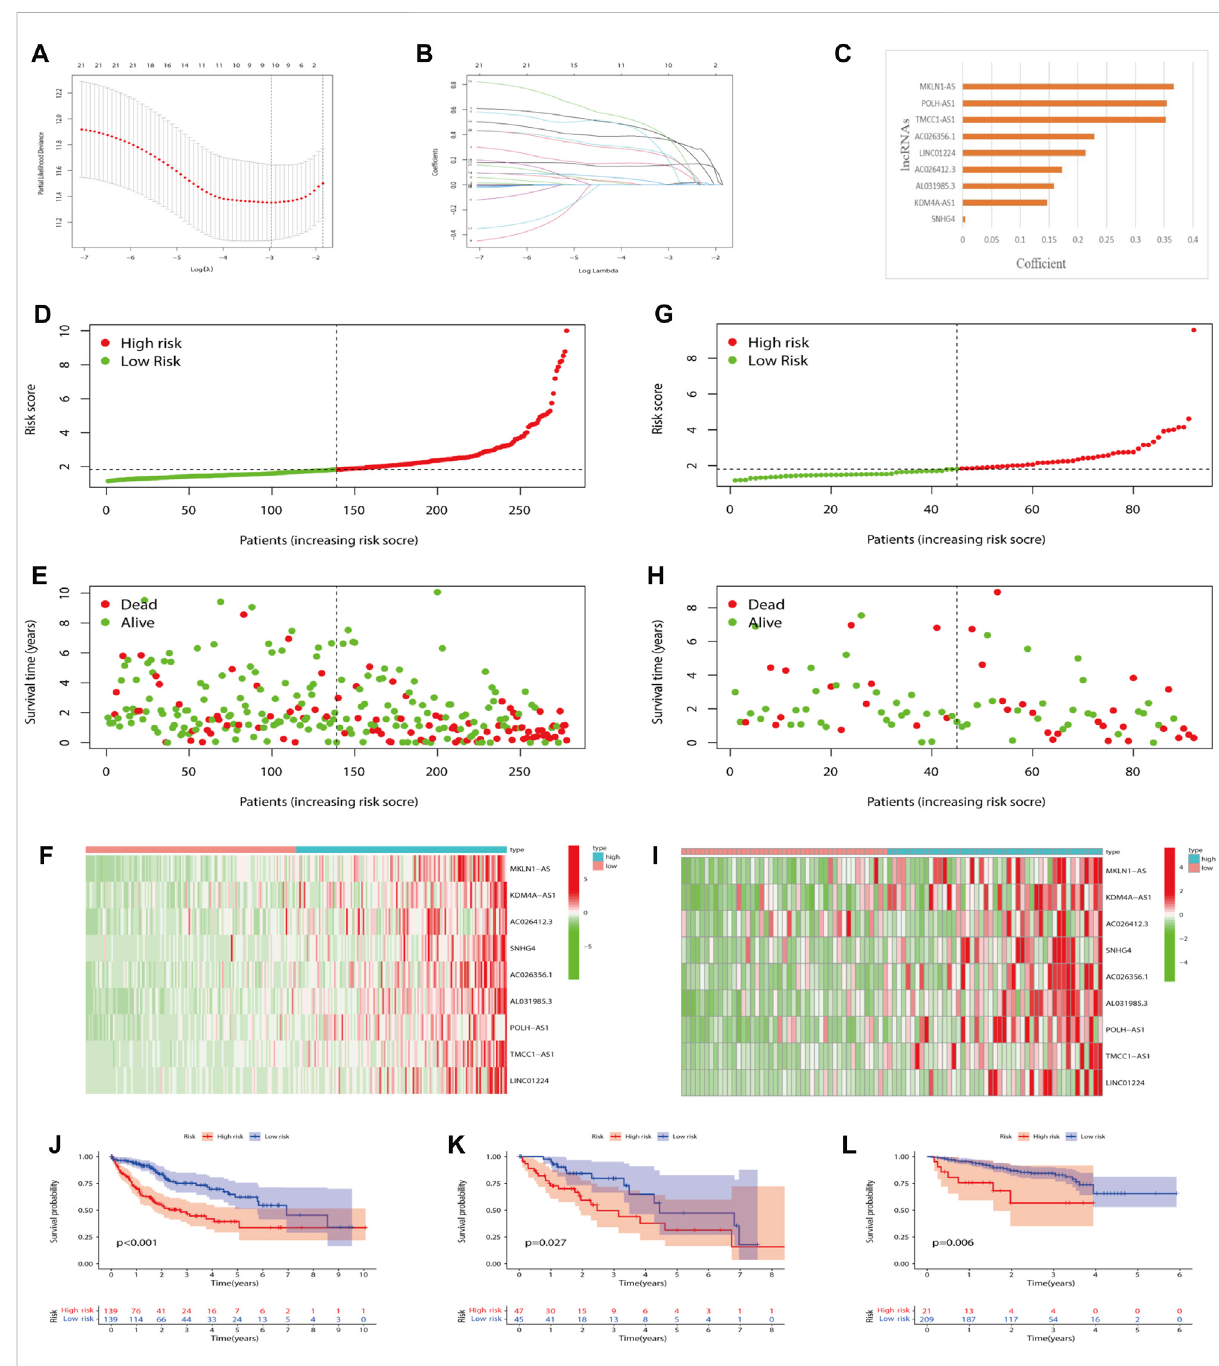
FIGURE 4 Prognostic value of the m7G-LPS. (A – C) LASSO regression was performed (A) , and the optimal criteria (B) and coef fi cients (C) were calculated. (D – I) Risk plots, survival state, and heatmap of HCC patients at low- and high-risk scores in training (D – F) and testing set (G – I) . (J – L) Kaplan – Meier analysis in training, testing and ICGC set. m7G, N7-methylguanosine; lncRNAs, long non-coding RNAs. m7G-LPS, m7G-related lncRNA prognostic signature; LASSO, Least absolute shrinkage and selection operator; HCC, hepatocellular